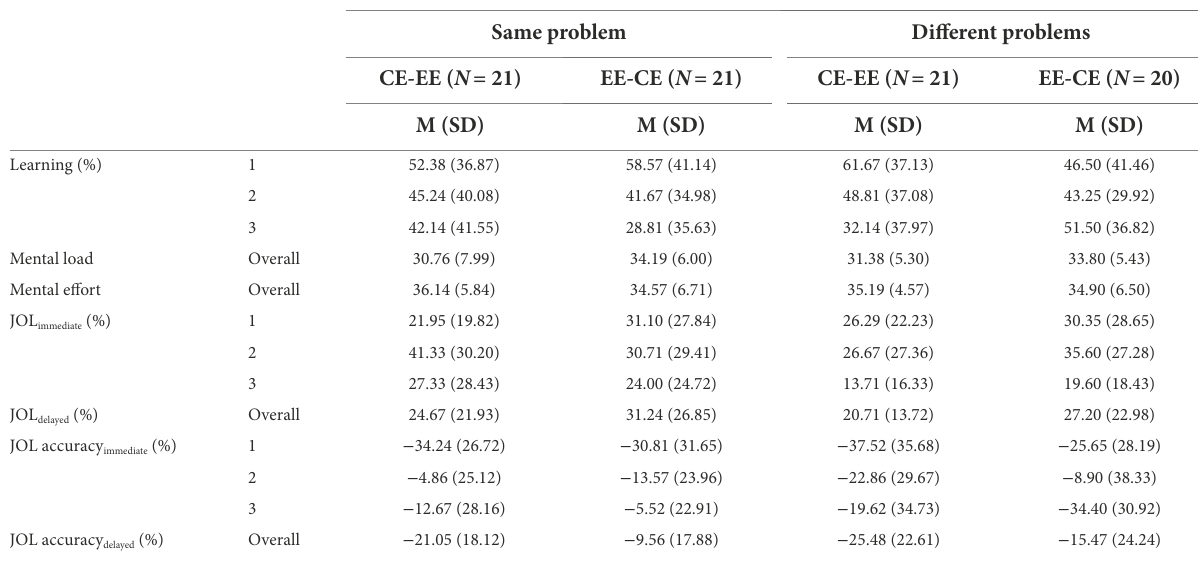
TABLE 1 Descriptive statistics for all experimental